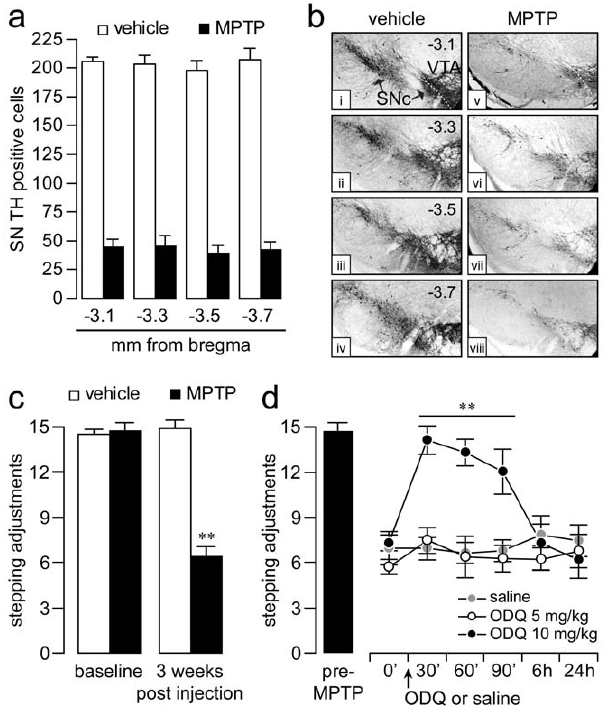
Figure 5. Systemic ODQ administration improves stepping performance in chronic MPTP-treated mice. ( a ) Chronic MPTP treatment significantly reduced the number of TH positive neurons in the SN. The data were collected at four anatomical levels from vehicle or MPTP-treated mice 3 weeks following the last injection (** P , 0.005 compared to vehicle). ( b ) Images of TH immunostaining showing the degree of reduction of TH positive cells in the SN at four anatomical levels (mm from bregma): 2 3.1 ( i, v ), 2 3.3 ( ii, vi ), 2 3.5 ( iii, vii ) and 2 3.7 ( iv, viii ). ( c ) Summary graph depicting the effect of chronic saline (n=9) or MPTP (20 mg/kg, s.c., n=13) injections on forelimb